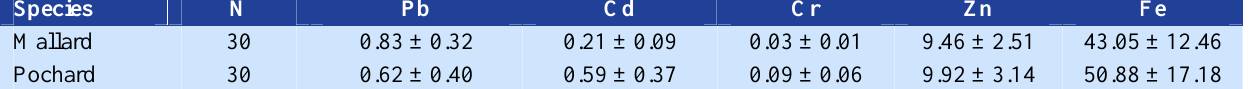
Table 1. Metal concentrations (mean ± Standard deviation) in the pectoral muscle of mallard and pochard collected from wetlands in the South Eastern region of the Caspian Sea Species